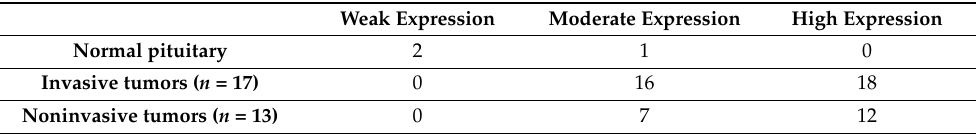
Table 2. The results of assessment of immunoreactivity against L1-ORF1p in nonfunctioning go- nadotroph